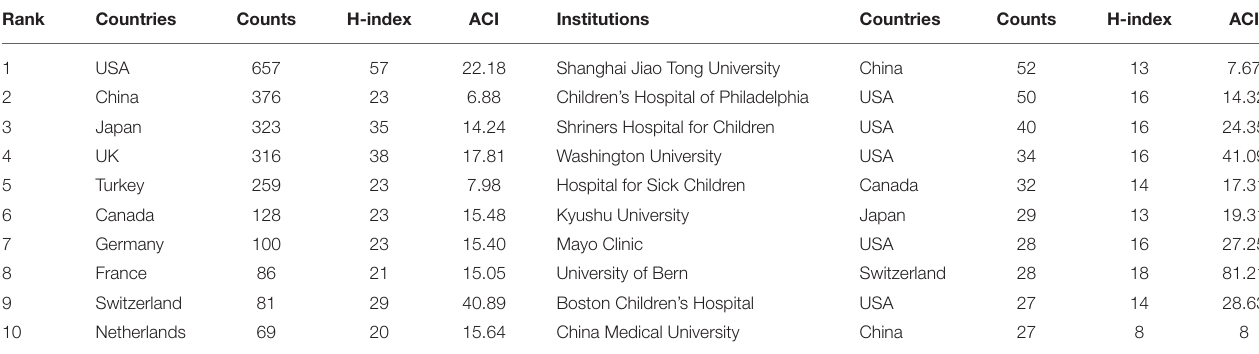
TABLE 1 | Top 10 countries and institutions contributed to research publications in the developmental dysplasia of the hip (DDH) field.